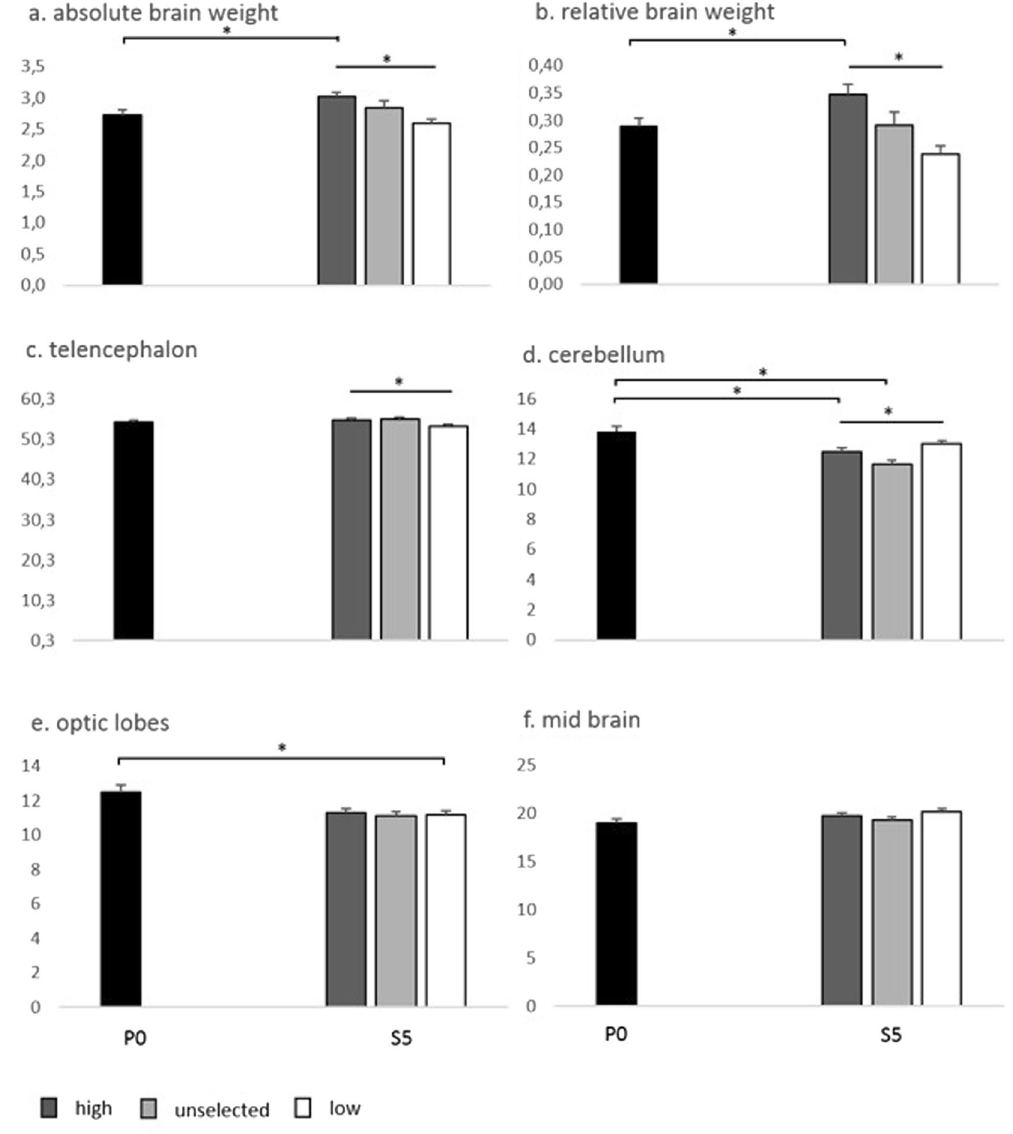
Figure 3. Average brain weights ( + / − SEM) in the parental generation (P0) and the three selection lines in the fifth selected generation (S5). ( a ) Absolute weight in g of the brain; ( b ) Relative weight of the brain in % of body weight; ( c – f ); Relative weight of different brain parts in % of total brain weight. * P <